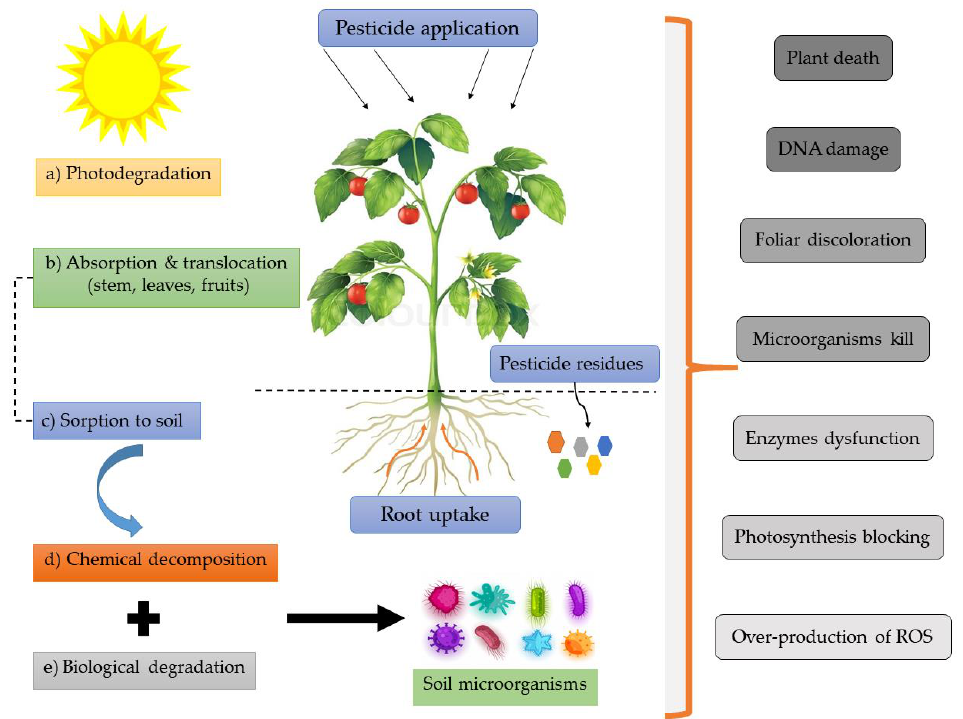
Figure 7. Mechanistic pathway of pesticides toxicity in soil and plant.